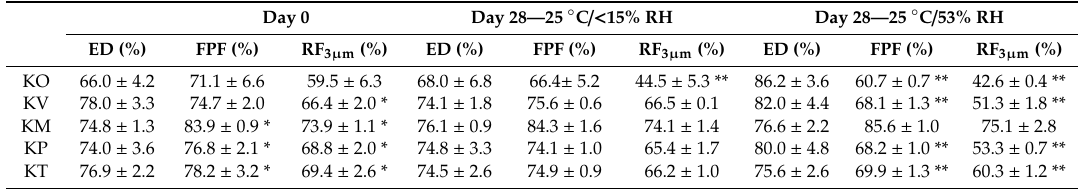
Table 3. Summary of the emitted dose (ED) (%) and fine particle fraction (FPF) of the different formulations (kanamycinonly(KO), kanamycin-valine(KV),kanamycin-methionine(KM), kanamycin-phenylalanine (KP), and kanamycin-tryptophan (KT)) on day 0 and day 28 when stored at 25 ◦ C /< 15% RH or 25 ◦ C / 53% RH. Values are expressed as mean ± standard deviation, n = 3. * The value is significantly ( p < 0.05) di ff erent compared to the FPF or RF 3 µ m of KO on day 0. ** The value significantly ( p < 0.05) decreased compared to the FPF or RF 3 µ m of the formulation on day